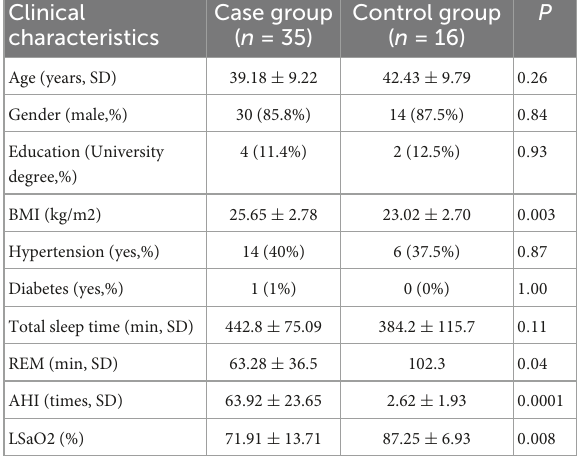
TABLE 1 Characteristics of the study population. Clinical